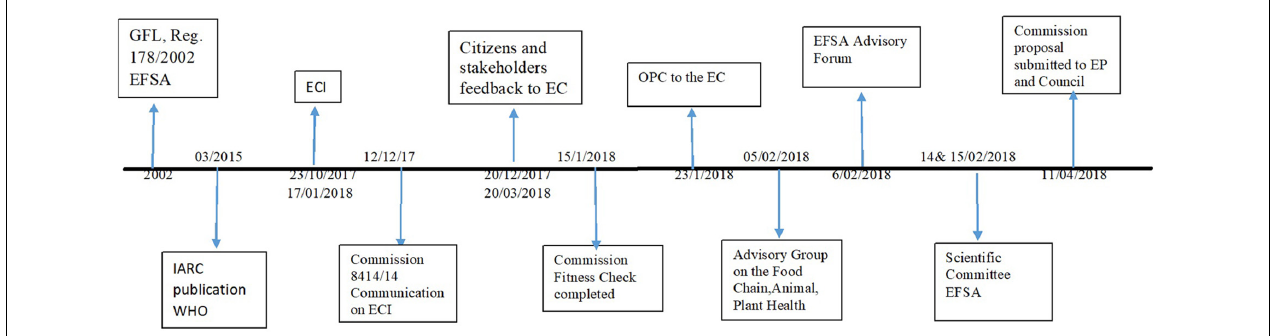
FIGURE 1 | Timeline of events in relation to the Commission’s legislative proposal for GFL until the EC submitted its proposal to EP and